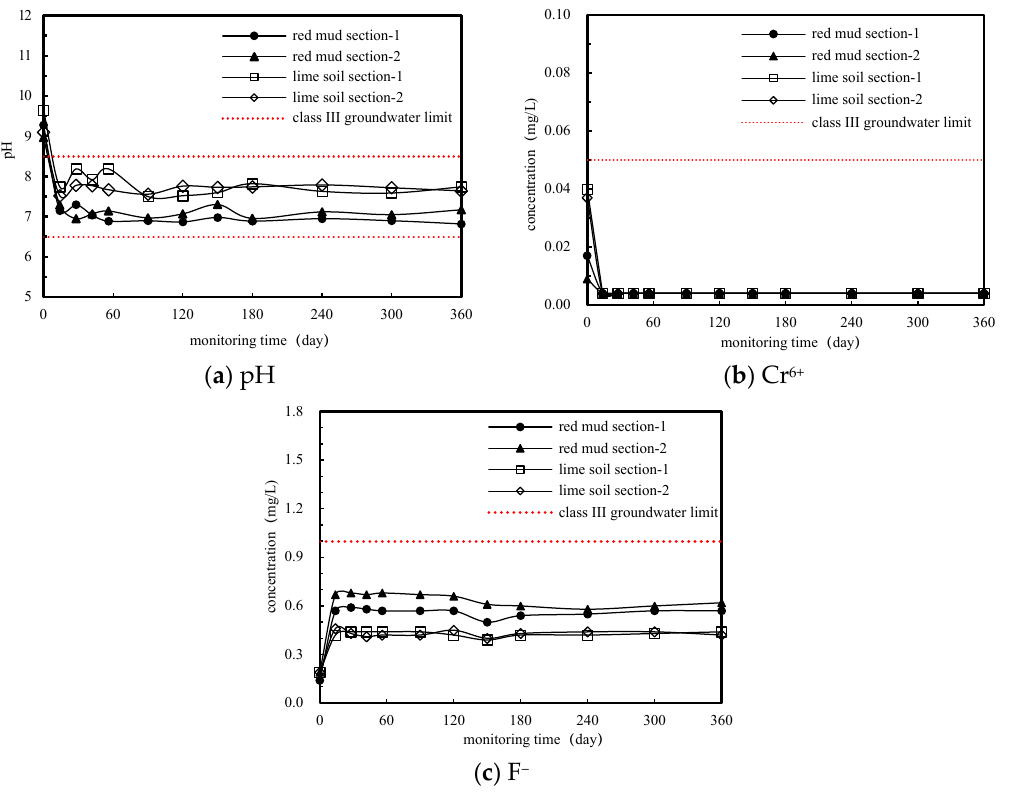
Figure 7. Typical indexes pH, Cr 6+ and F - in groundwater samples as a function of time.